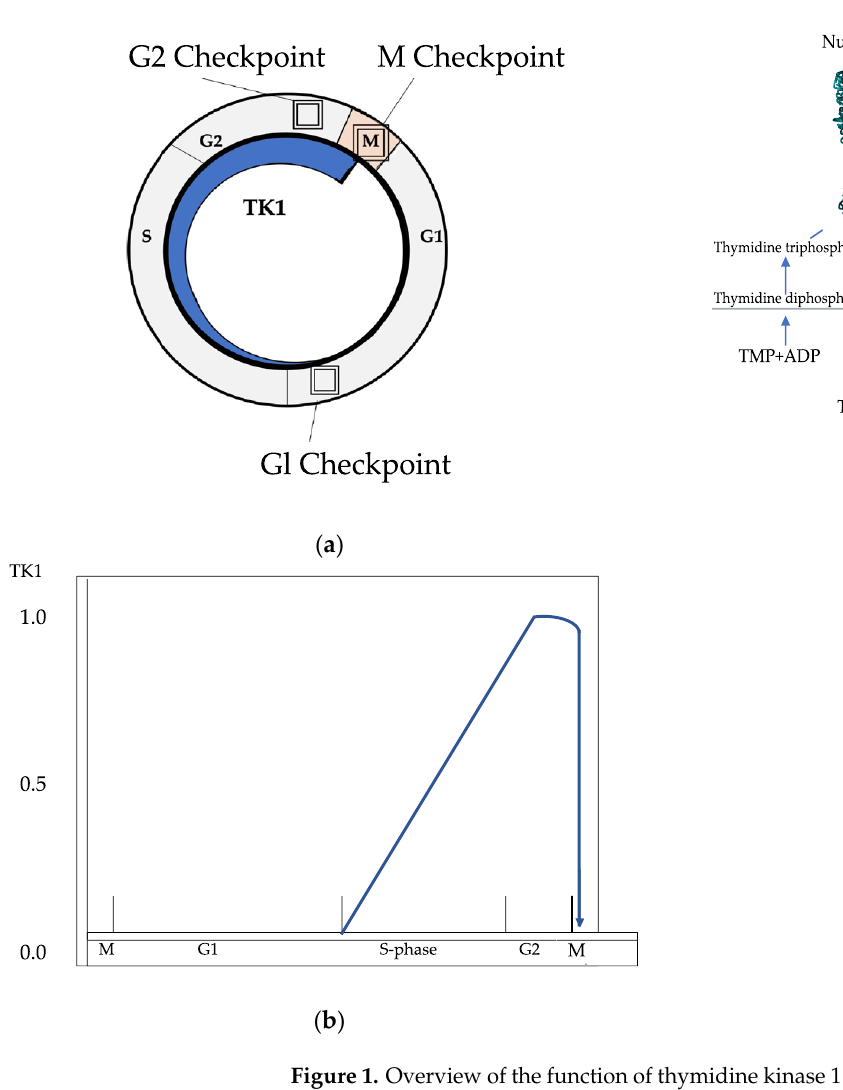
Figure 1. Overview of the function of thymidine kinase 1 in the DNA synthesis. ( a ) TK1 and cell cycle, ( b ) TK1 concentration during cell cycle, ( c ) transformation of thymidine* (Thd) to deoxythymidine — monophosphate